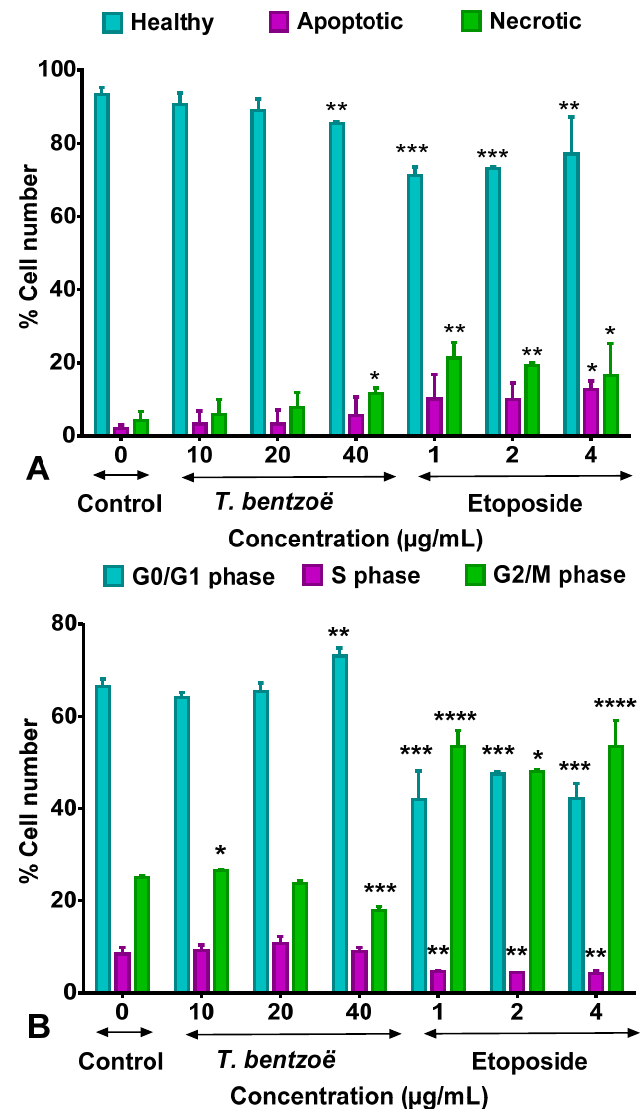
Figure 2. Effect of Terminalia bentzoë and etoposide on HepG2 cells as analyzed by flow cytometry. ( A ) Annexin V ‐ FITC/PI staining of HepG2 cells after 48 hours’ treatment and ( B ) cell cycle progression. Apoptosis and necrosis levels are expressed as percentage of the total cell population and given as mean ± SD ( n = 5). Percentage of cells in different phases (G0/G1, S and G2/M phases) are expressed as mean ± SD ( n = 3). Asterisks represent significant differences between test concentrations and dimethyl sulfoxide (DMSO) control. * p ≤ 0.05, ** p ≤ 0.01, *** p ≤ 0.001, **** p ≤ 0.0001.